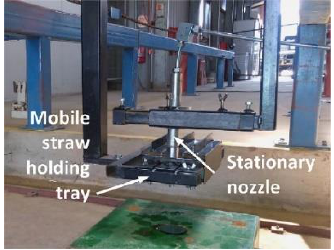
Figure 6. Bench tests of cutting wheat straw internode stem by water jet ([73], reproduced from “A laboratory evaluation of waterjet cutting of crop residue using the Aqua-Till ® liquid coulter” with permission from Elsevier, 2022).